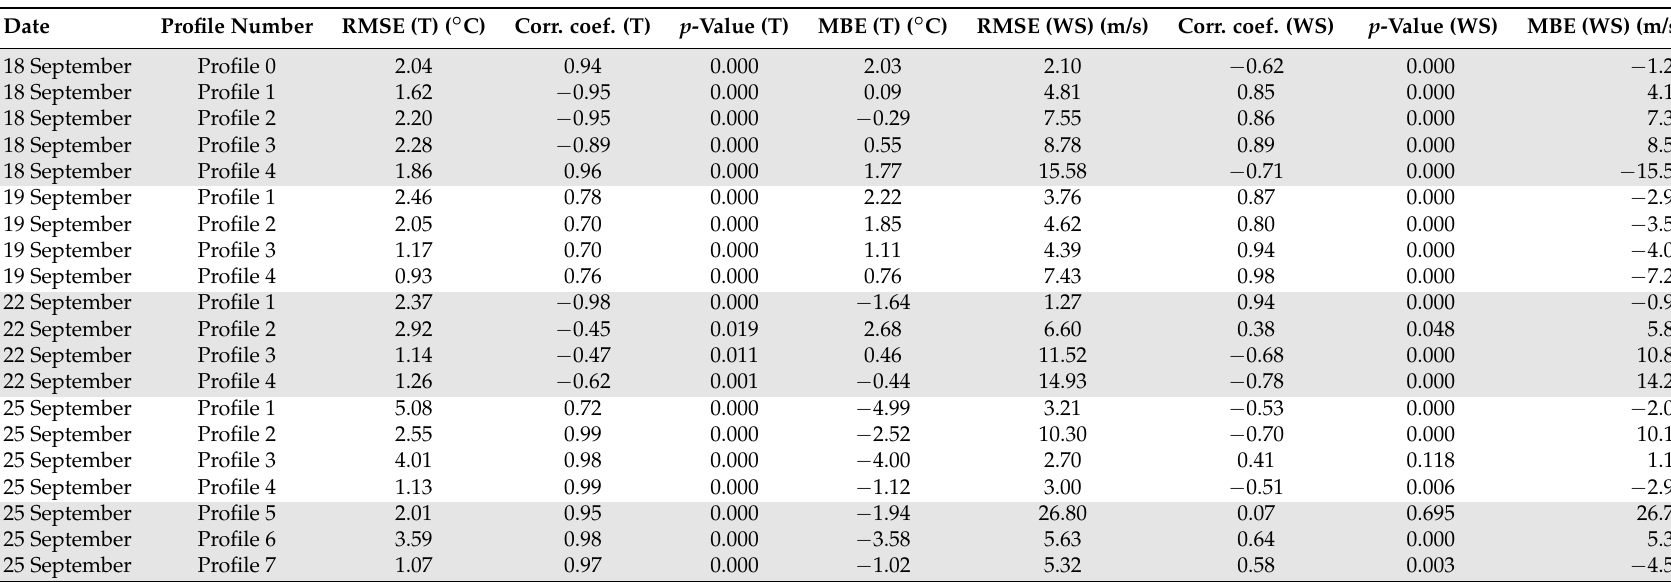
Table 3. Statistics for the comparison of AMPS results and UAS Aerosonde profiles in the lowest layer of the atmosphere ( ∼ 100–500 m). T—temperature, WS—wind